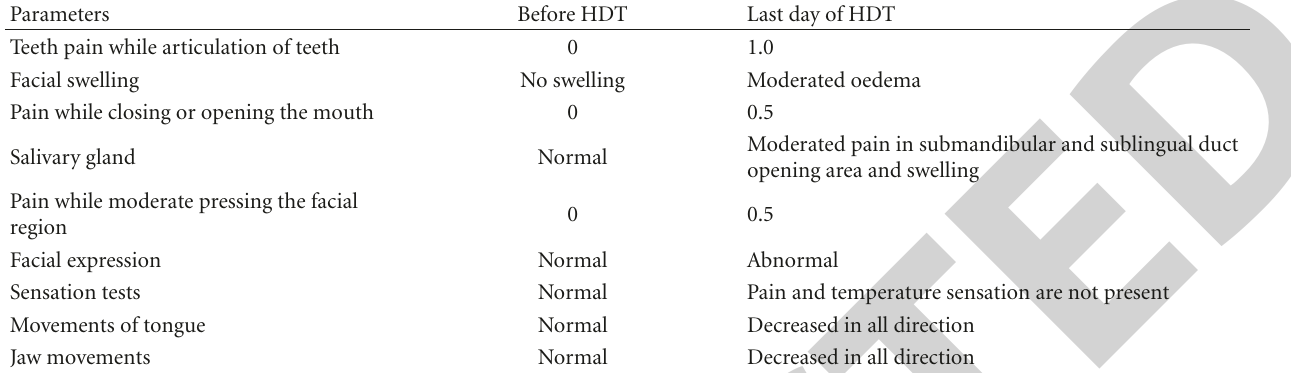
Table 3: The symptoms of subjects before and on last day of HDT in 10 healthy